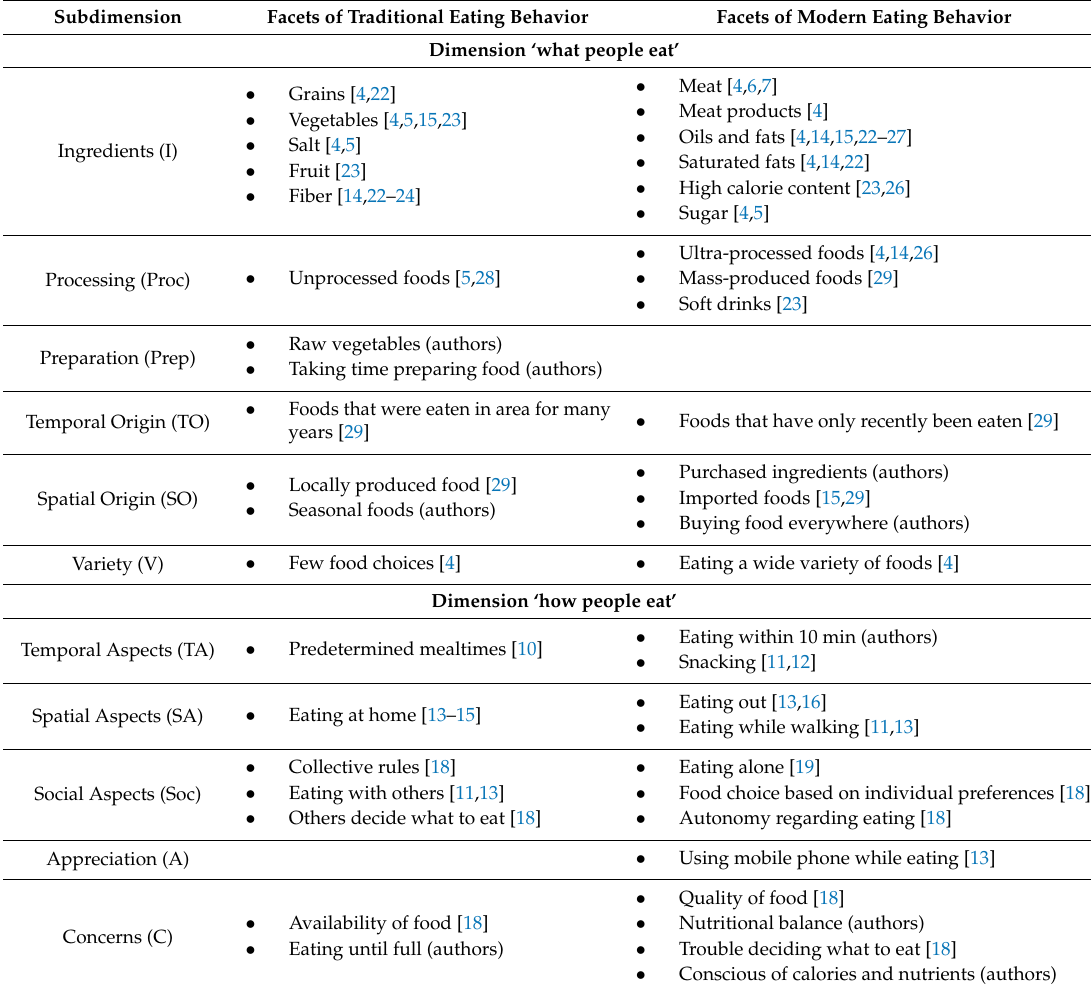
Table 1. Facets, subdimensions, and dimensions of traditional and modern eating